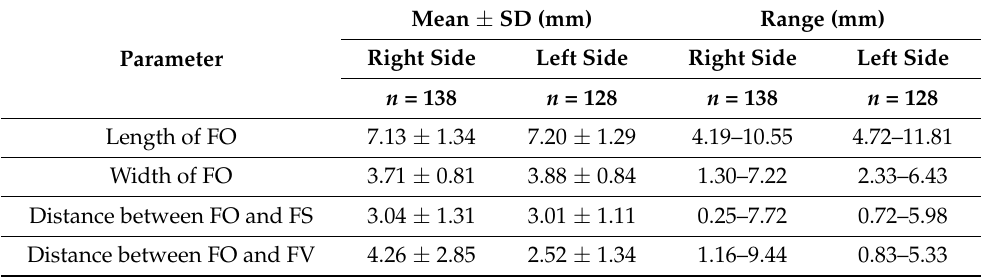
FO—foramen ovale. FS—foramen spinosum. FV—foramen of Vesalius. SD—standard deviation.